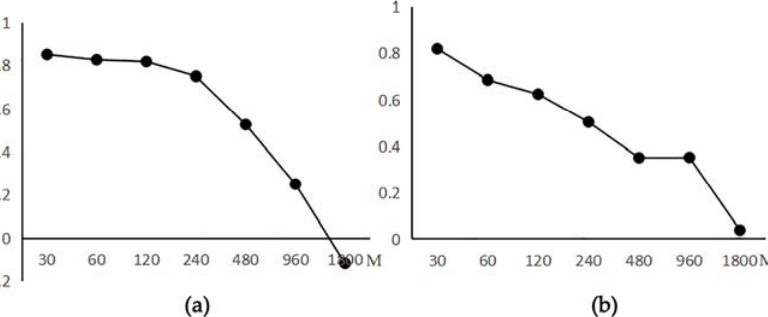
Figure 6. Synthesis index of integral connectivity: ( a ) synthesis index of ecological connectivity; and ( b ) synthesis index of recreational connectivity.